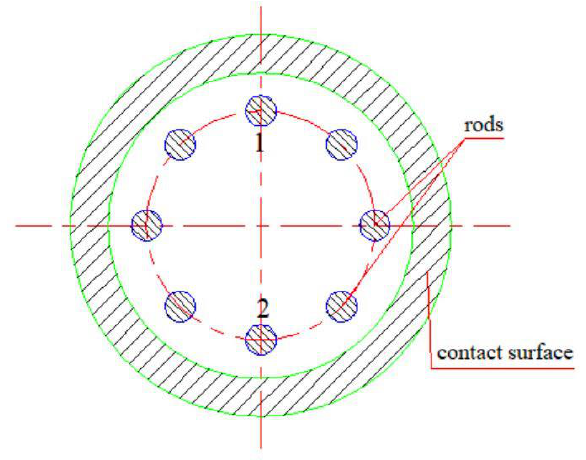
Figure 3. Circumferential tie rod distribution on the cross-section of the rotor .